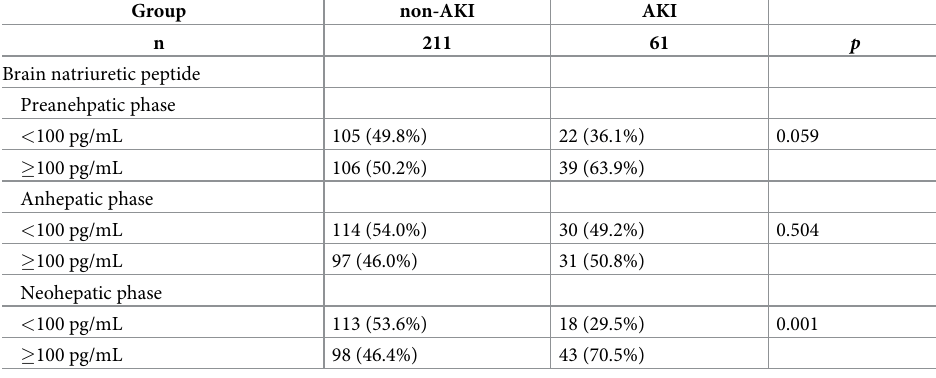
Table 5. Incidences of high serum levels of brain natriuretic peptide ( � 100 pg/mL) between non-acute kidney injury and acute kidney injury groups during living donor liver